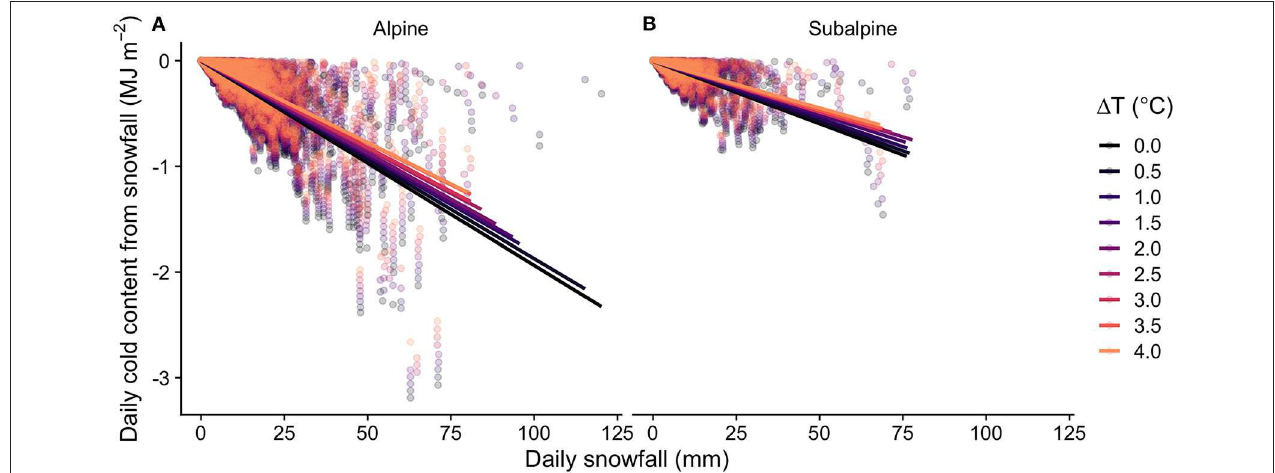
FIGURE 5 | Daily cold content additions from snowfall plotted against daily snowfall for the 1 T perturbations in the alpine (A) and subalpine (B) . The solid lines of best fit were computed using ordinary least squares regression and show a decrease in cold content from snowfall with increasing air temperatures (all p -values < 0.0005).